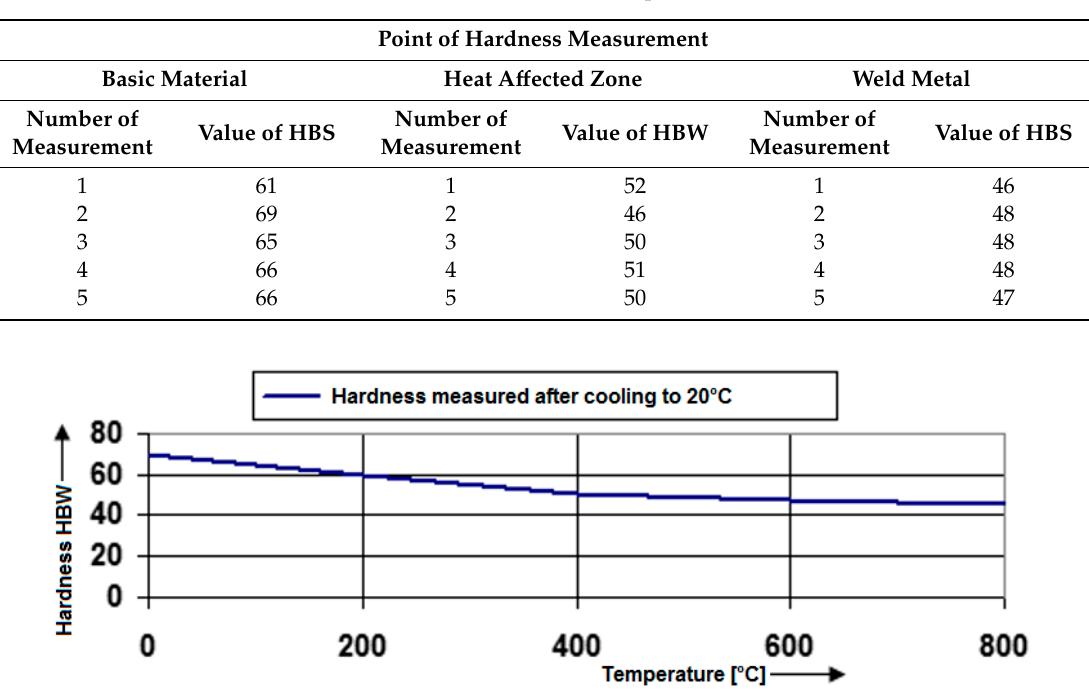
Table 1. The measurement of sample hardness.